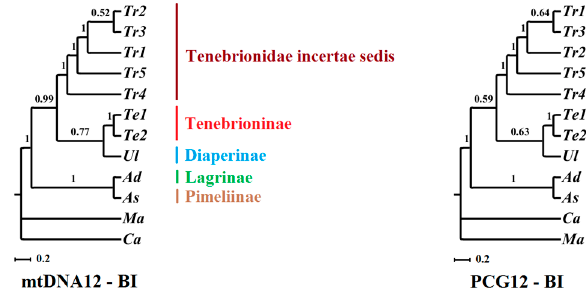
Figure 8. Phylogeny of the six subfamilies in Tenebrionidae. Phylogenetic trees were inferred from four datasets by using Bayesian inference (BI) method. Applicable bootstrap values were shown close to the nodes.